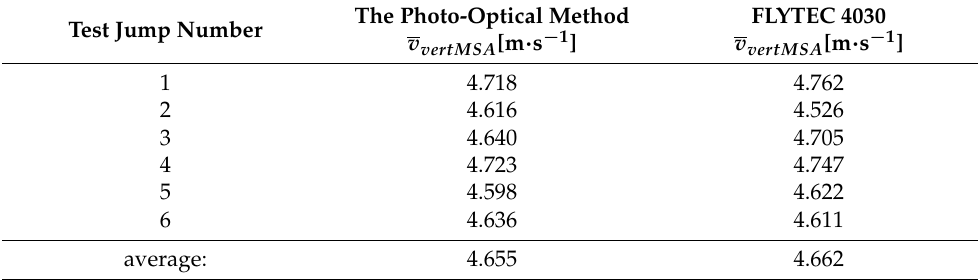
Table 5. Overall results of the test jumps number 1 to